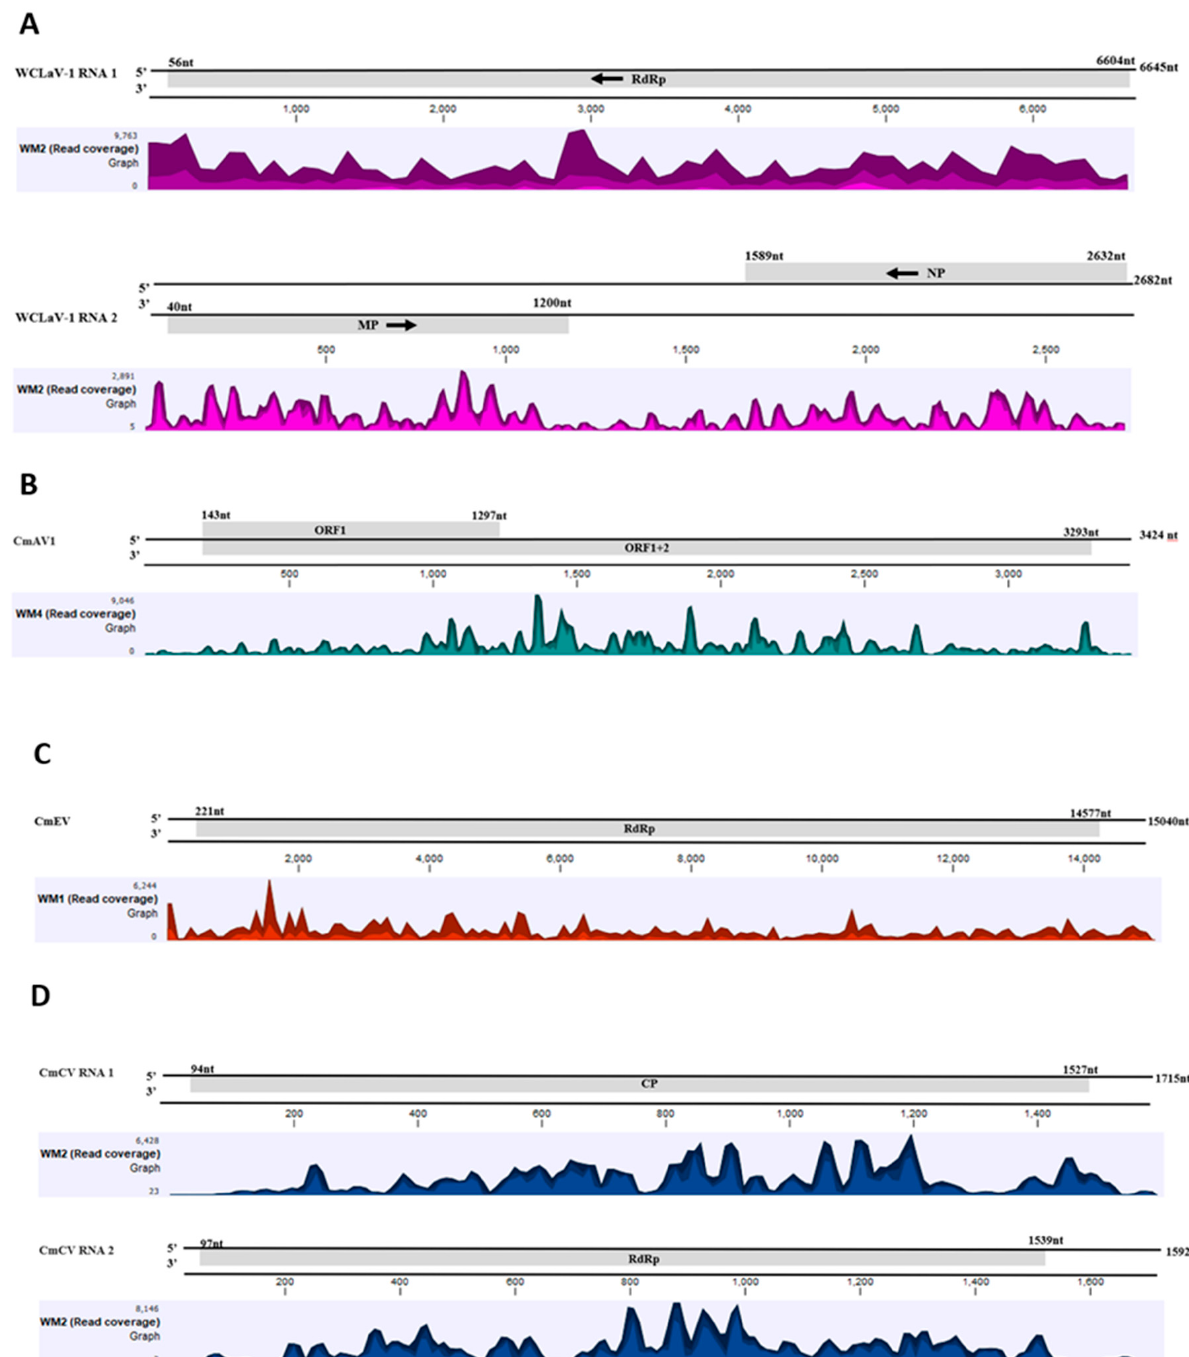
Figure 3. Read coverage maps of the virus genomes detected by HTS of small RNAs of symptomatic watermelon and cantaloupe from Georgia. Watermelon crinkle leaf-associated virus 1 (WCLaV-1) ( A ), cucumis melo amalgavirus 1 (CmAV1) ( B ), cucumis melo endornavirus (CmEV) ( C ), and cucumis melo cryptic virus (CmCV) ( D ). Genome positions of the virus are presented to scale above the histograms and the coverage in number of reads is represented on the Y -axis. Within the specified aggregation bucket, the colors mean: the maximum, average, and the minimum coverage values (read counts), from top to bottom.